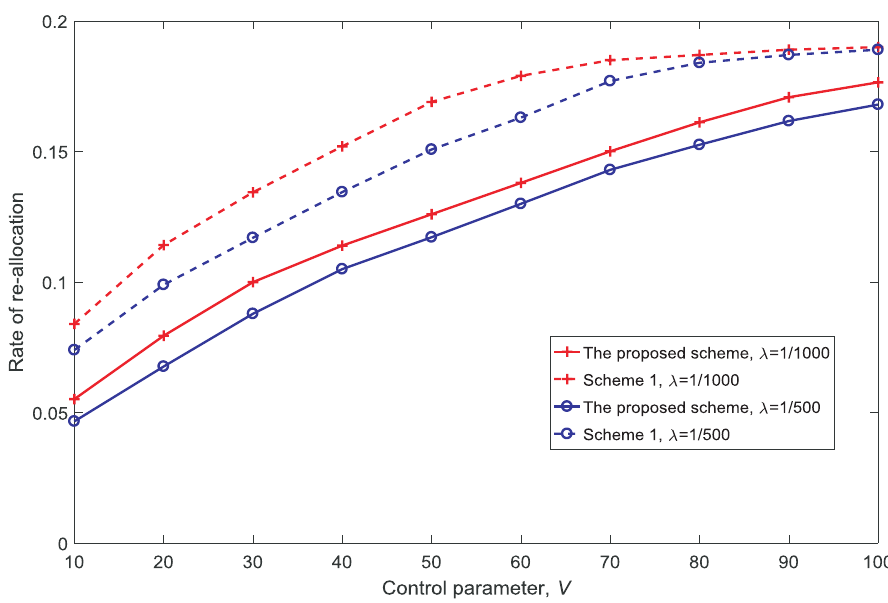
Figure 14. Rate of re-allocation for different control parameter values V ( d V = 10, K = 3, N = 5 ) .